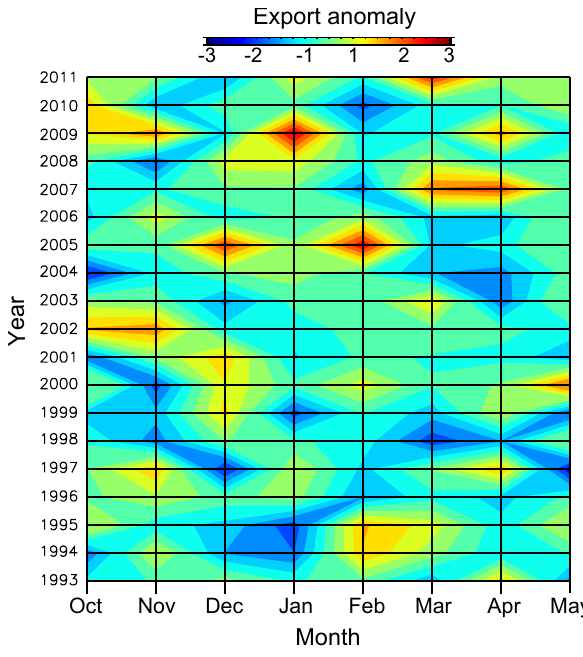
Fig. 6. Normalized monthly total ice area flux anomalies between October and May (1992–2011).